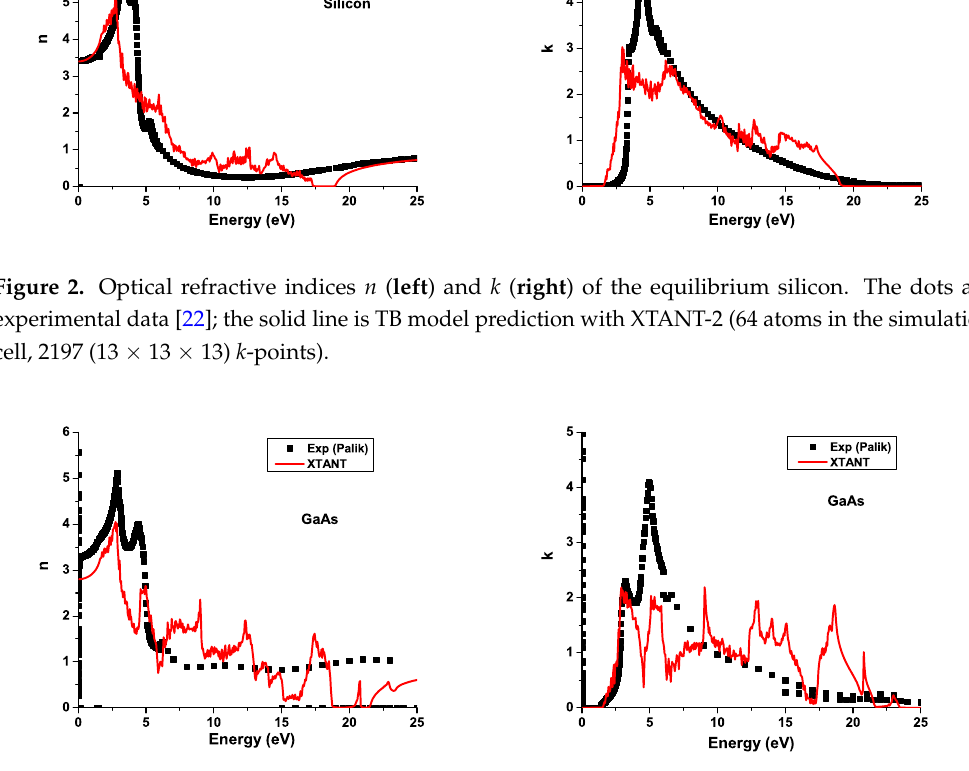
Figure 3. Optical refractive indices n ( left ) and k ( right ) of the equilibrium GaAs. The dots are experimental data [22]; the solid line shows TB model prediction with XTANT-2 (64 atoms in the simulation cell, 2197 (13 × 13 × 13) k